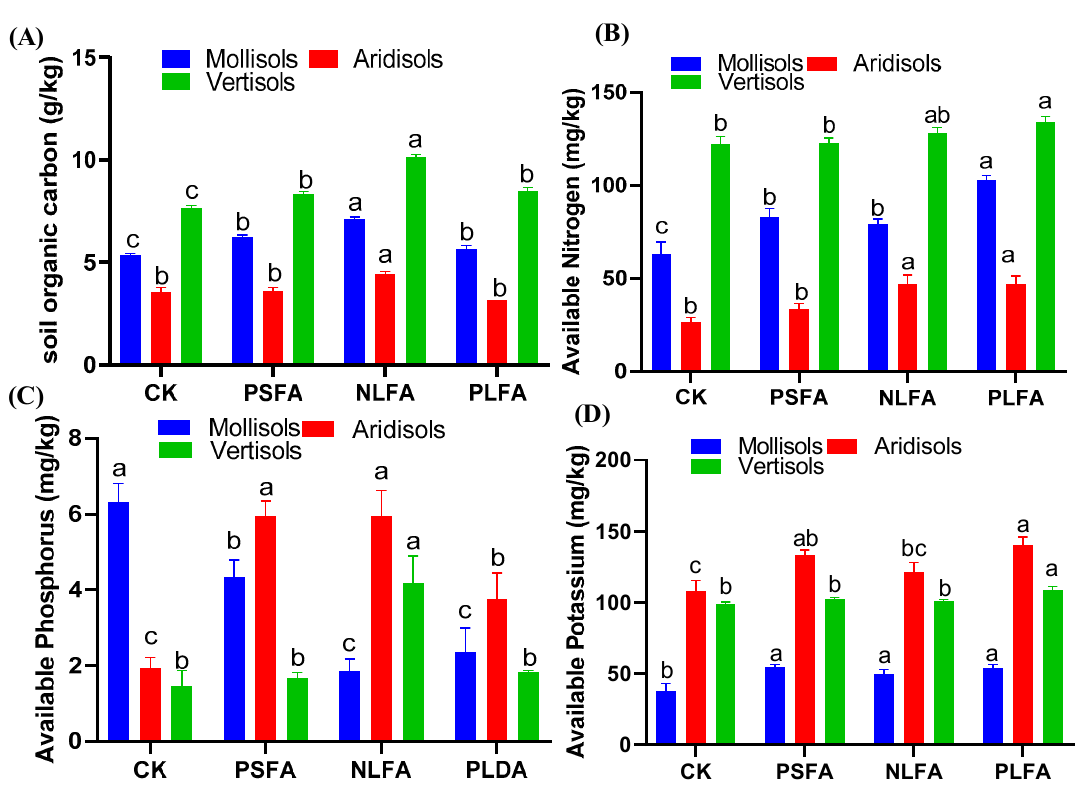
Figure 3. The e ff ect of plant-derived solid fulvic acid (PSFA), mineral-derived liquid fulvic acid (NLFA), and plant-derived liquid fulvic acid (PLFA) on ( A ) soil organic carbon, ( B ) available nitrogen, ( C ) available phosphorus and ( D ) available potassium content of Mollisols, Aridisols, and Vertisols soils. The means ± standard errors are shown ( n = 4). Different letters (a, b, and c) indicate significant differences between the initial and final values of the soils based on a least significant difference test at a 5% significance level. Table 1. Effect of FAs on organic–inorganic degree compounds and organic–inorganic composites (g / kg). FA